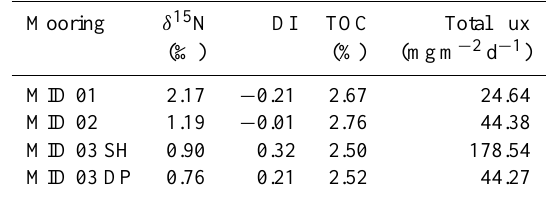
Table 3. Sediment trap moorings in the Ierapetra Deep: mean val- ues of δ 15 N, DI, TOC and total flux.